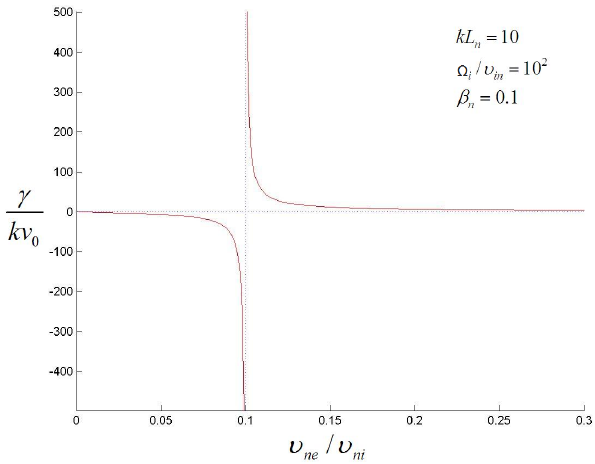
Fig.1a Plot based on Eq. (12) with an asymptote at 0.1 Fig. 1a. Plot based on Eq. (12) with an asymptote at 0.1.